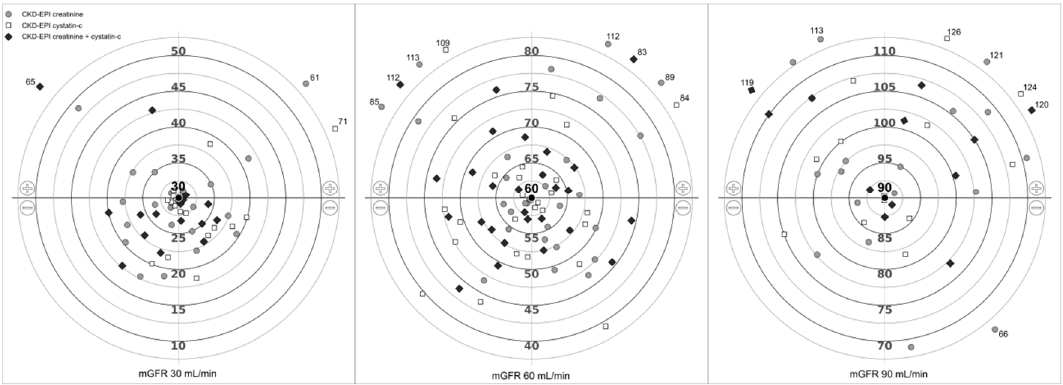
Figure 1. Bias of the three Chronic Kidney Disease Epidemiology Collaboration (CKD-EPI) equations (creatinine and/or cystatin-C based) for those patients with measured GFR of 30 mL/min ( left ), 60 mL/min ( middle ), and 90 mL/min ( right ).